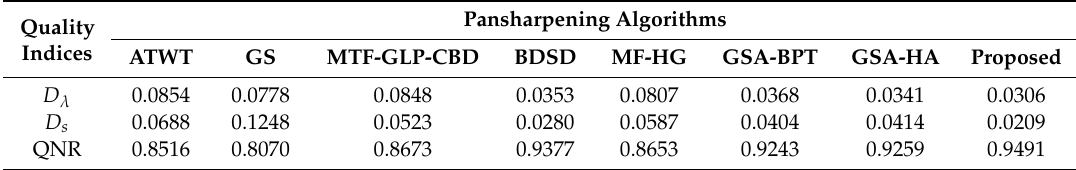
Table 5. Objective quantitative indices obtained by compared methods for real QuickBird data